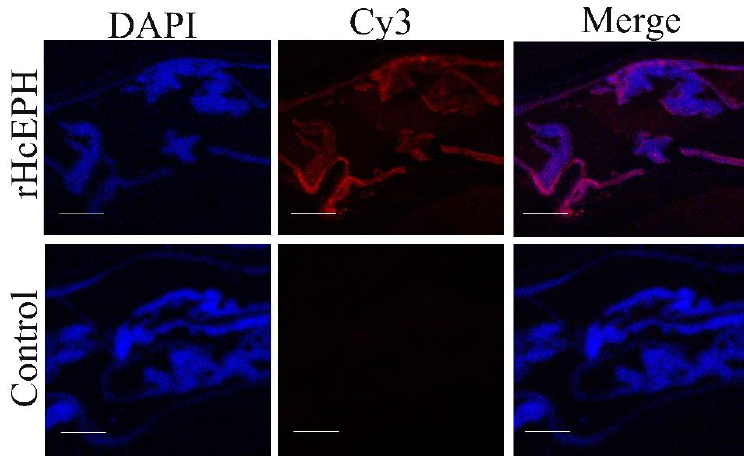
Figure 2. Localization of HcEPH within adult H. contortus by immunofluorescence assay. The red color indicates the localization of target protein stained with Cy3 in adult worms and blue color indicate the localization of nuclei stained with DAPI. Merge image of DAPI (blue color) and Cy3 (red color). No red fluorescence was observed in control. Scale-bars 40 µm.